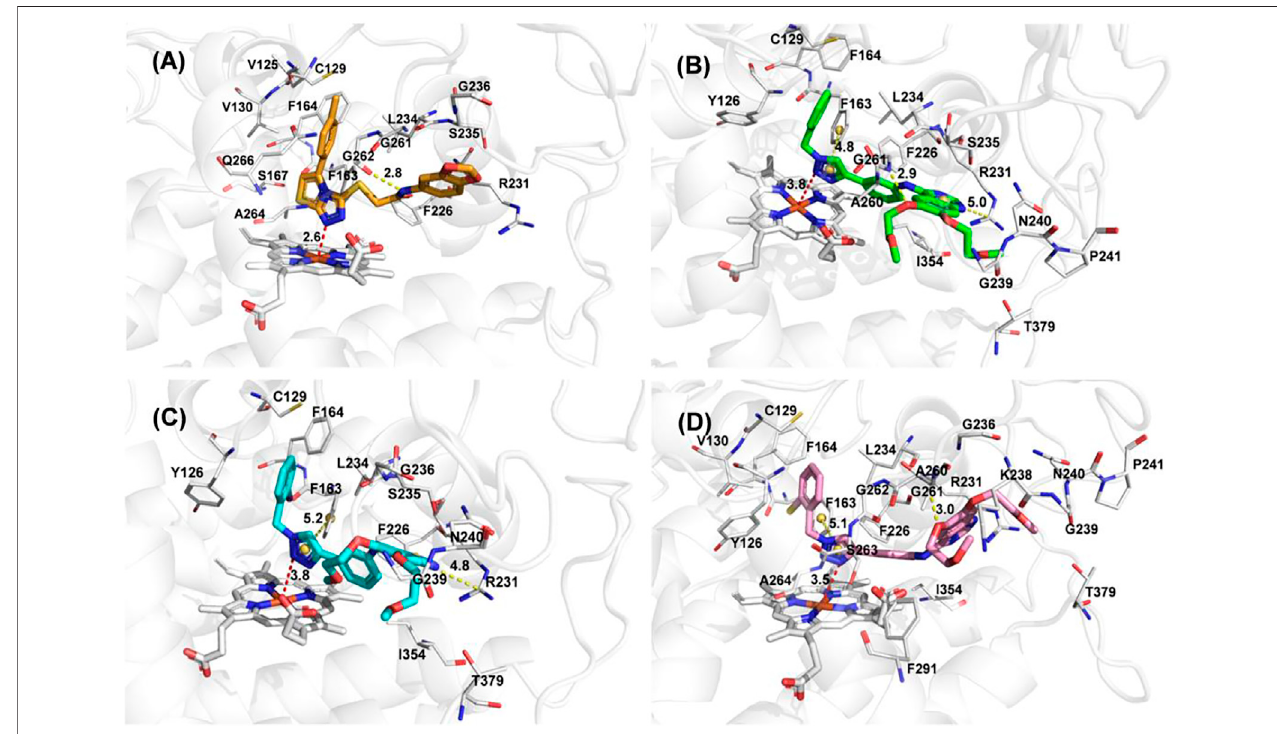
FIGURE 7 | (A) The docking conformation of compound Amg-1 (orange) with IDO1. (B) The docking binding mode of compound b (green) with IDO1. (C) The docking binding mode of compound d (cyan) with IDO1. (D) The docking binding mode of compound e (pink) with